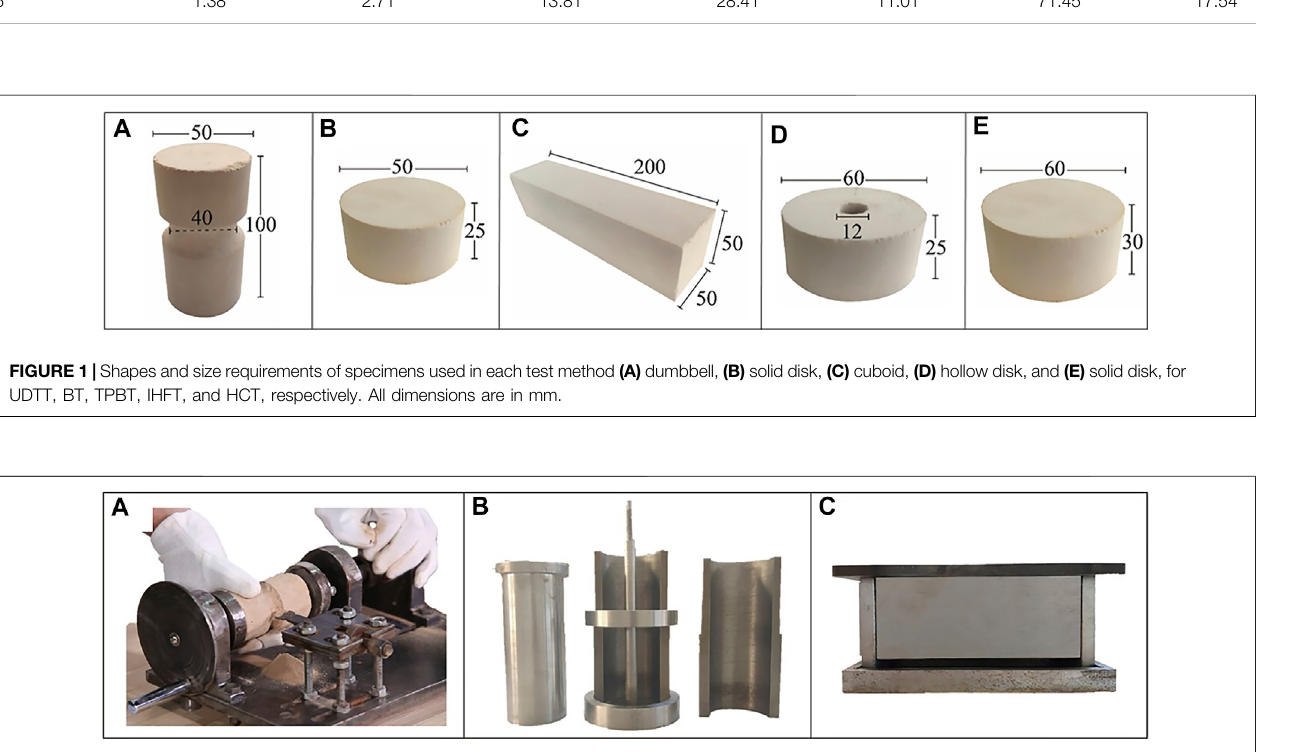
FIGURE 2 | Devices for specimen preparation (A) rotation grooving device (Li et al., 2020) (B) annular specimen mold (Li et al., 2020), and (C) soil beam mold.